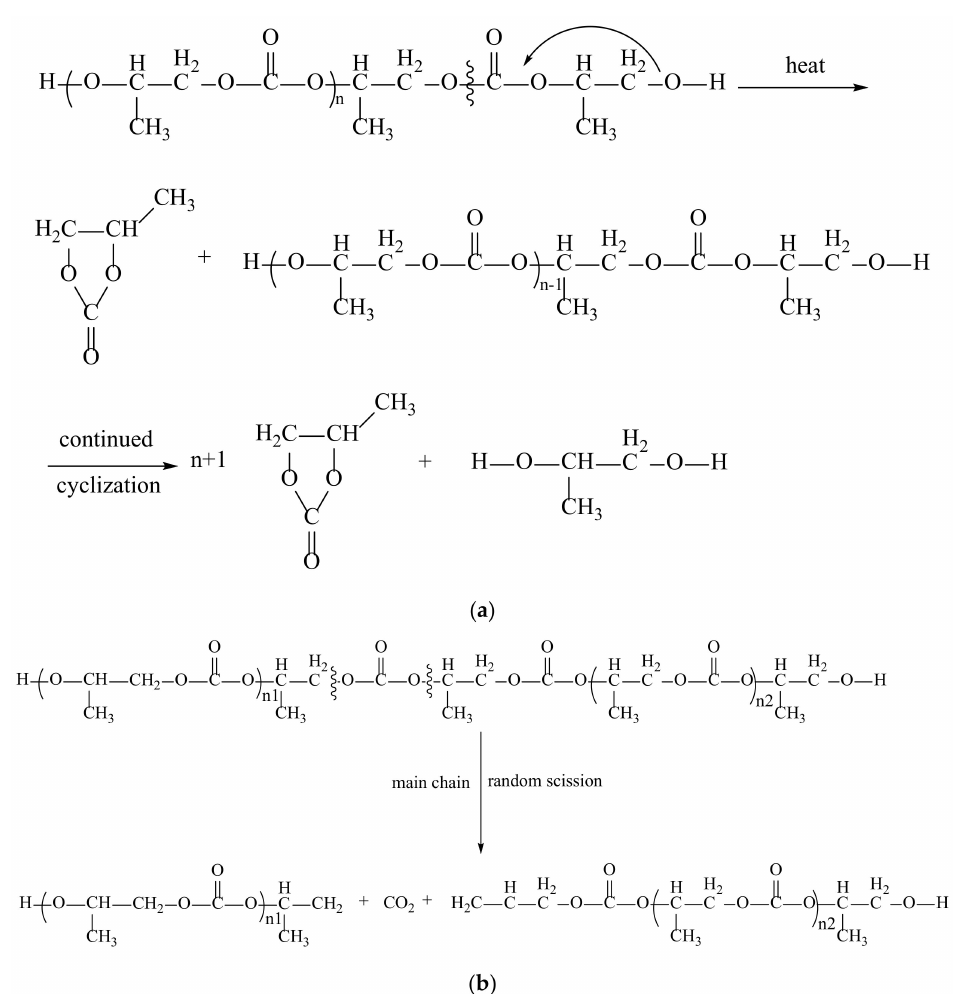
Figure 5. Thermal degradation of PPC. ( a ) Unzipping degradation; ( b ) unconventional chain-breaking degradation